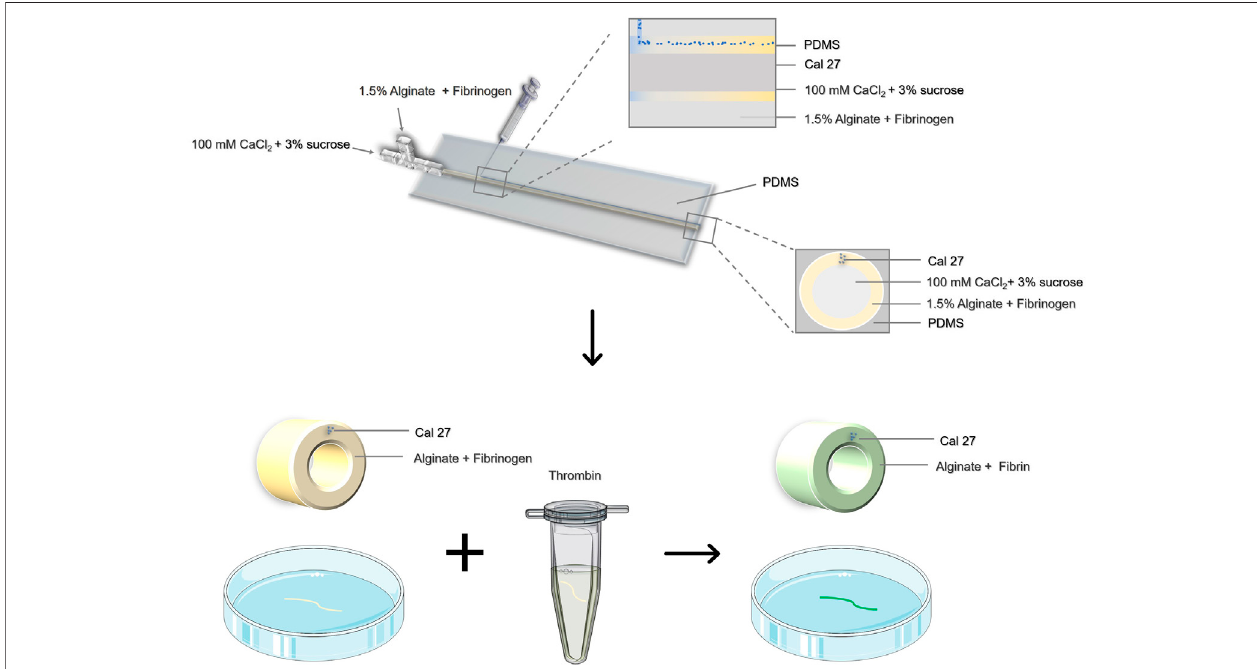
FIGURE 1 | Schematic illustration of the preparation of cell-containing hydrogel microtubes by coaxial microinjection device.